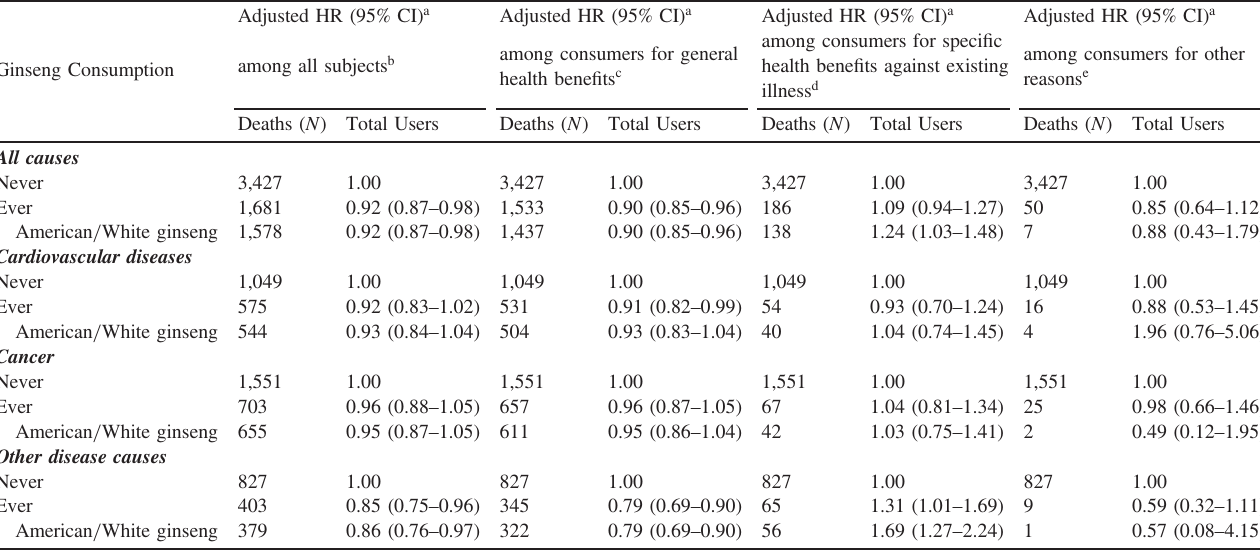
Table 2. HRs a and 95% CIs of mortality associated with ginseng use, Shanghai Women ’ s Health Study